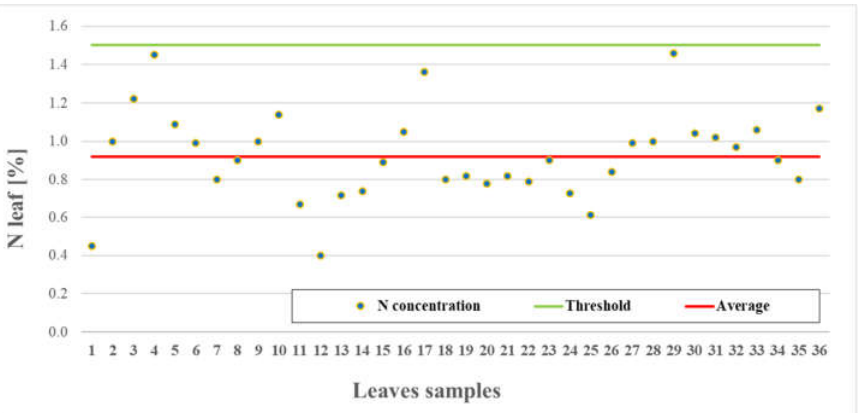
Figure 3. Nitrogen concentration determined on 36 leaf samples uniformly collected from olive plants. The red line represents the average of the whole samples, while the green line represents the threshold. The canopy area was extracted from the NDVI map (Figure 4) and enable to design the vigor ratio among the neighbouring plants before obtaining the prescription map, as explained in the materials and methods.